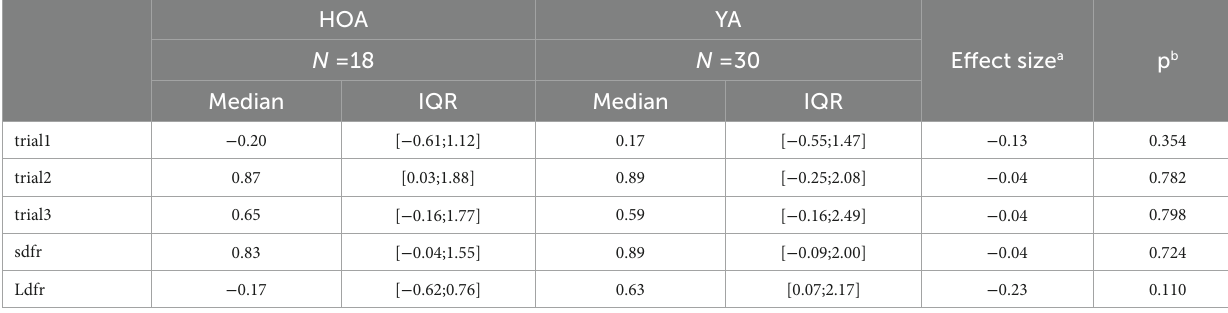
TABLE 1 Median and interquartile range of the serial clustering index.